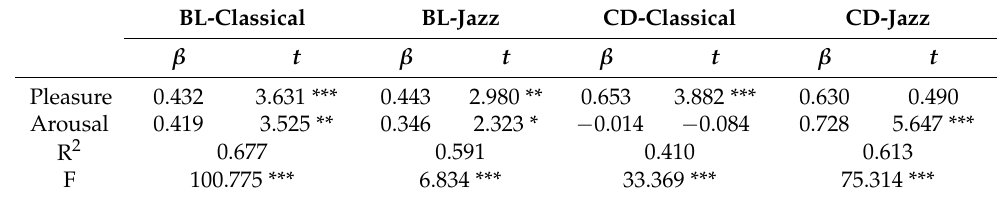
Table 8. Results of the multiple regression analysis of the influence of consumers’ emotions during their dining experience on their behavioral responses under different background music conditions ( n =